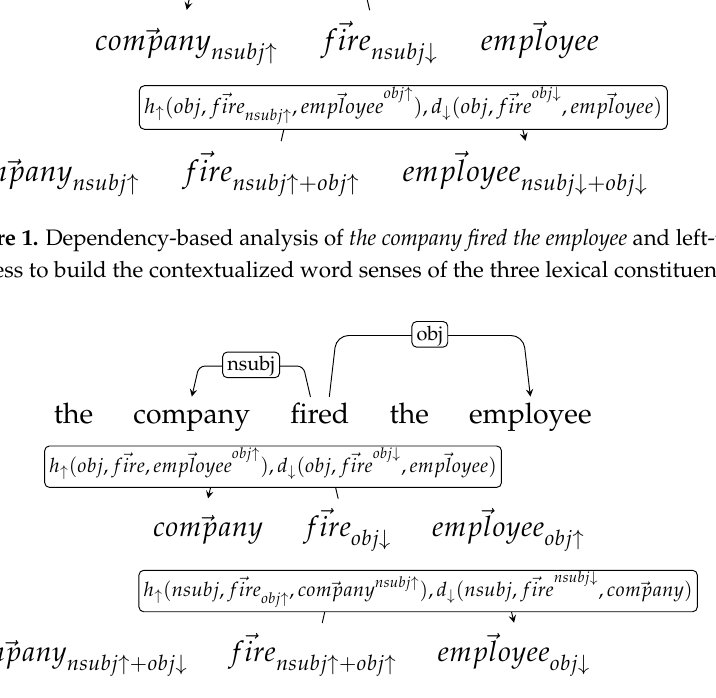
Figure 2. Dependency-based analysis of the company fired the employee and right-to-left interpretation process to build the contextualized word senses of the three lexical constituents.